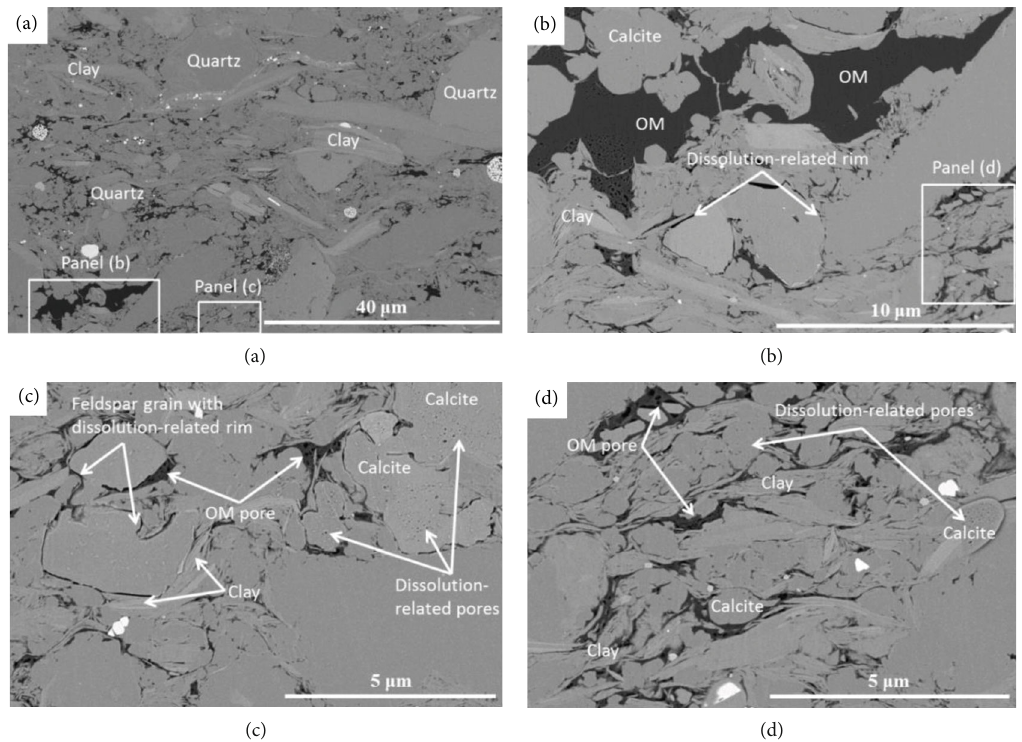
Figure 8: FE-SEM images of argillaceous/siliceous mixed shales (M). (a) Back-scattered electron of argillaceous/siliceous mixed shale lithofacies. There are many silt-sized quartz particles in argillaceous/siliceous mixed shale sample. (b) Large OM particles in argillaceous/siliceous mixed shale, but pores are less developed. (c) Dissolution-related rims in the boundary of feldspar. Dissolution- related pores in calcite are less connected. (d) OM-hosted pores in the residual OM